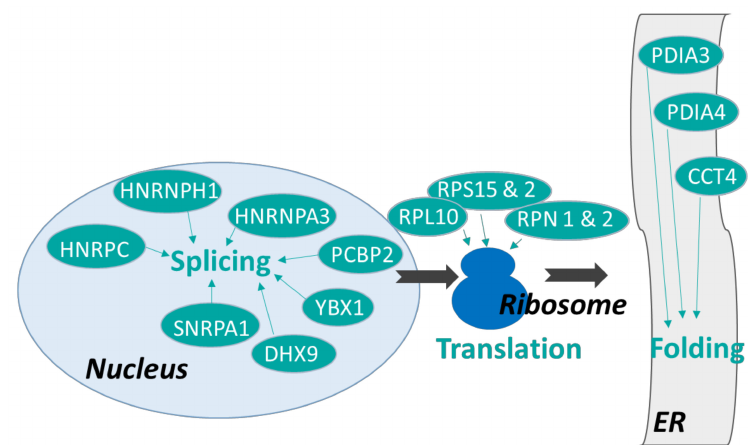
Figure 6. Identified differentially expressed genes are presented in their potential role in crucial steps of the control of gene expression. Green boxes indicate genes which are downregulated by nutritional restriction. Light and dark blue represent the nucleus and ribosomes, respectively. Grey boxes represent the endoplasmic reticulum. Differentially expressed proteins between restricted and control cows after four days of undernutrition for restricted cows during LPS